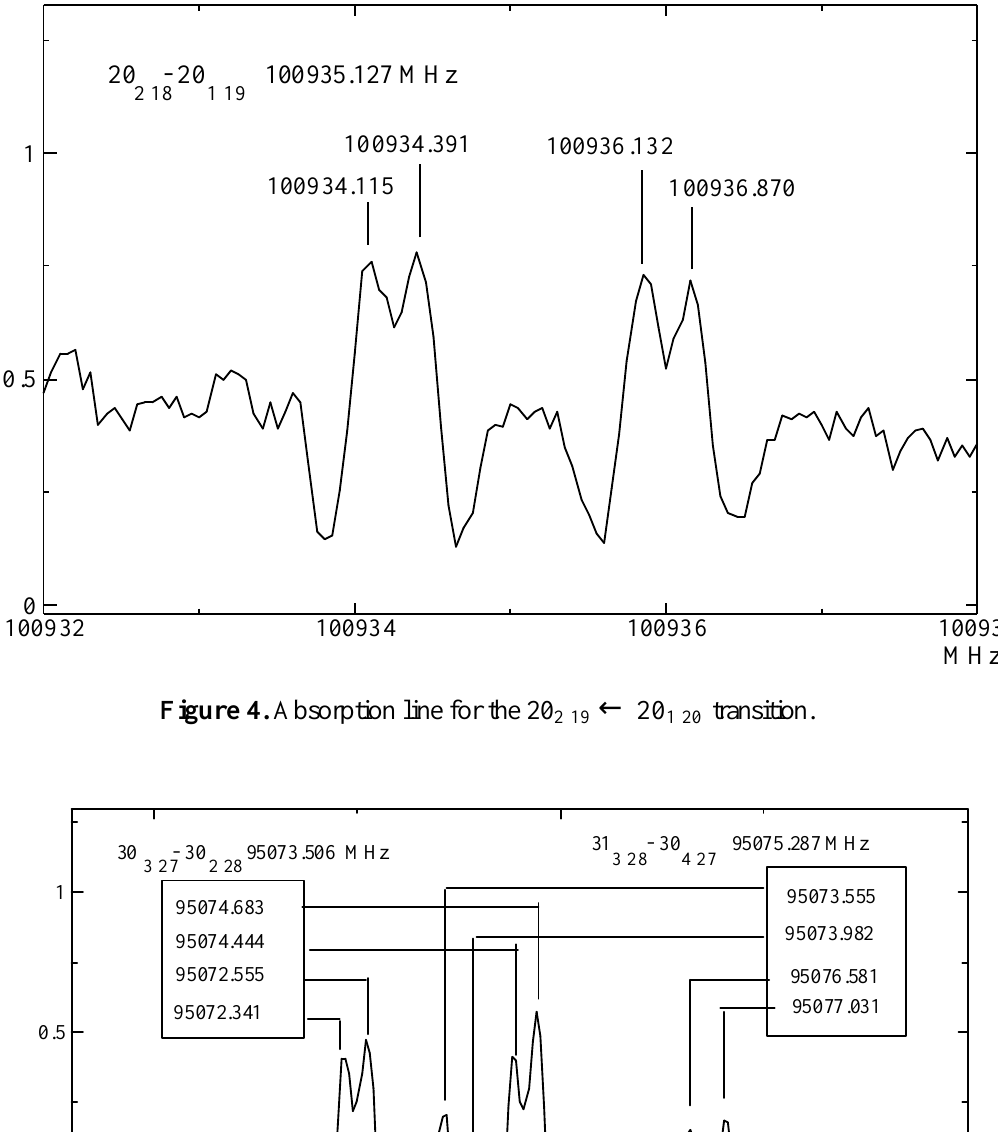
Figure 5 . Absorption lines for the 30 3 27 ‹ 30 2 28 and 31 3 28 ‹ 30 4 27